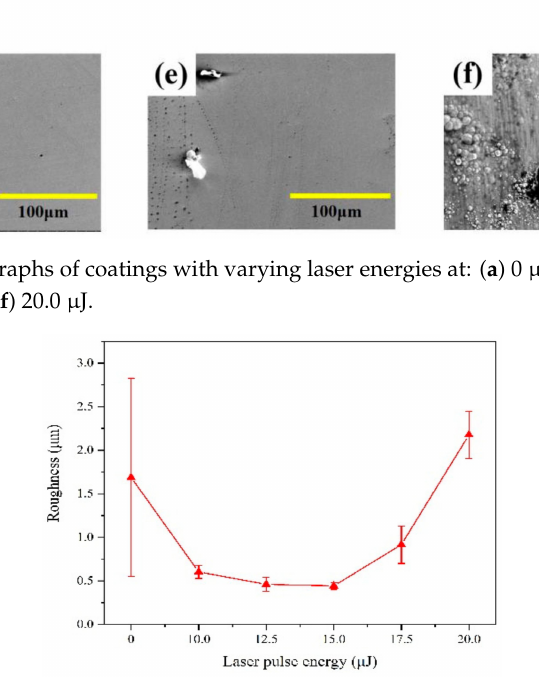
Figure 3. Surface roughness of coatings with varying laser